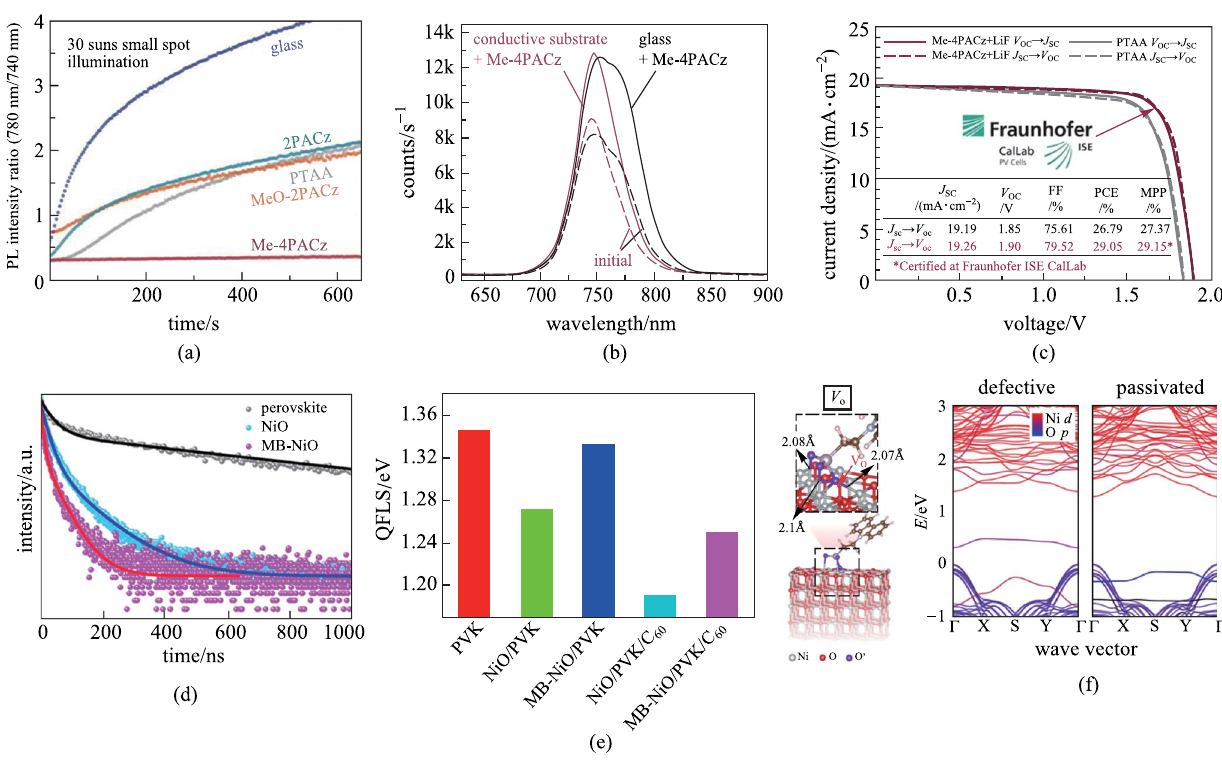
Fig. 8 a Ratio of PL intensities at 780 nm (I-rich domains) and 740 nm (neat perovskite) during PL evolutions at high illumination intensity. b PL spectra before (dashed lines) and after 600 s of light-soaking (solid lines) under 1-sun equivalent illumination in air, comparing the per- ovskite grown on Me-4PACz that had been deposited on a glass substrate and a conductive ITO substrate. c Certified J – V curve measured at Fraunhofer ISE, including the MPP value and the device parameters (red), in comparison to a tandem cell with PTAA (gray) as HTL measured in-house. d TRPL spectra of perovskite films deposited on PET, PET/ITO/NiO and PET/ITO/MB-NiO substrates. e Calculated QFLS of the perovskite film, HTL/perovskite and HTL/perovskite/electron transport layer junctions. f First-principles simulation of passivation effect of the phosphoryl group in the bridging molecule (that is, 2PACz ) on typical defects on NiO (O vacancy: VO ( e )) surfaces. a – c Reprinted with permis- sion from Ref. [60]. Copyright 2021, The American Association for the Advancement of Science. d – f Reprinted with permission from Ref.